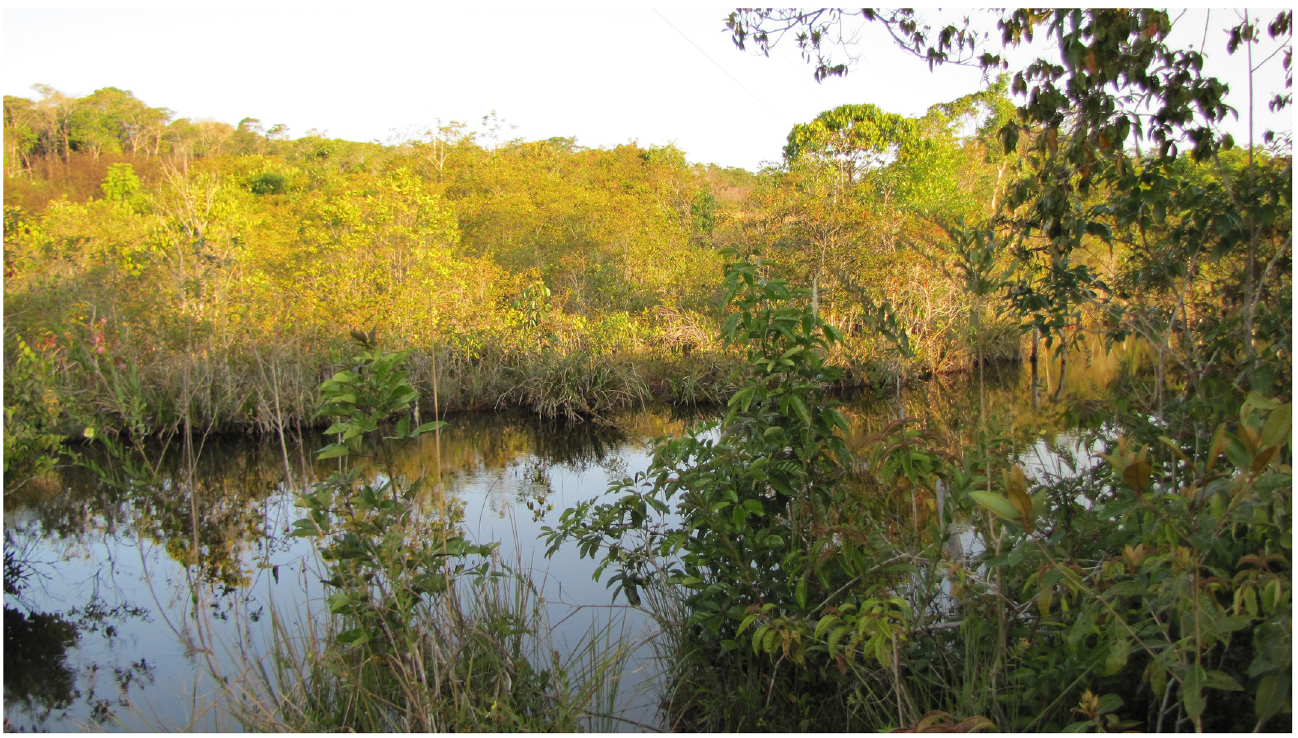
Fig 10. Photograph of rio Mutum, type locality of Eigenmannia sirius , illustrating